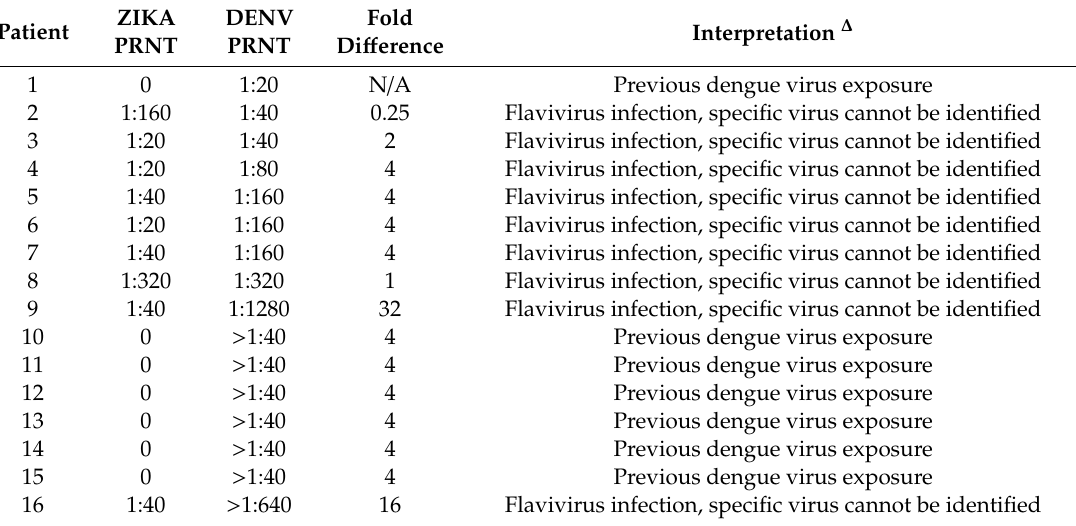
Table 2. Plaque-Reduction Neutralization Titers of patients with serological evidence of previous exposure to flaviviruses, including